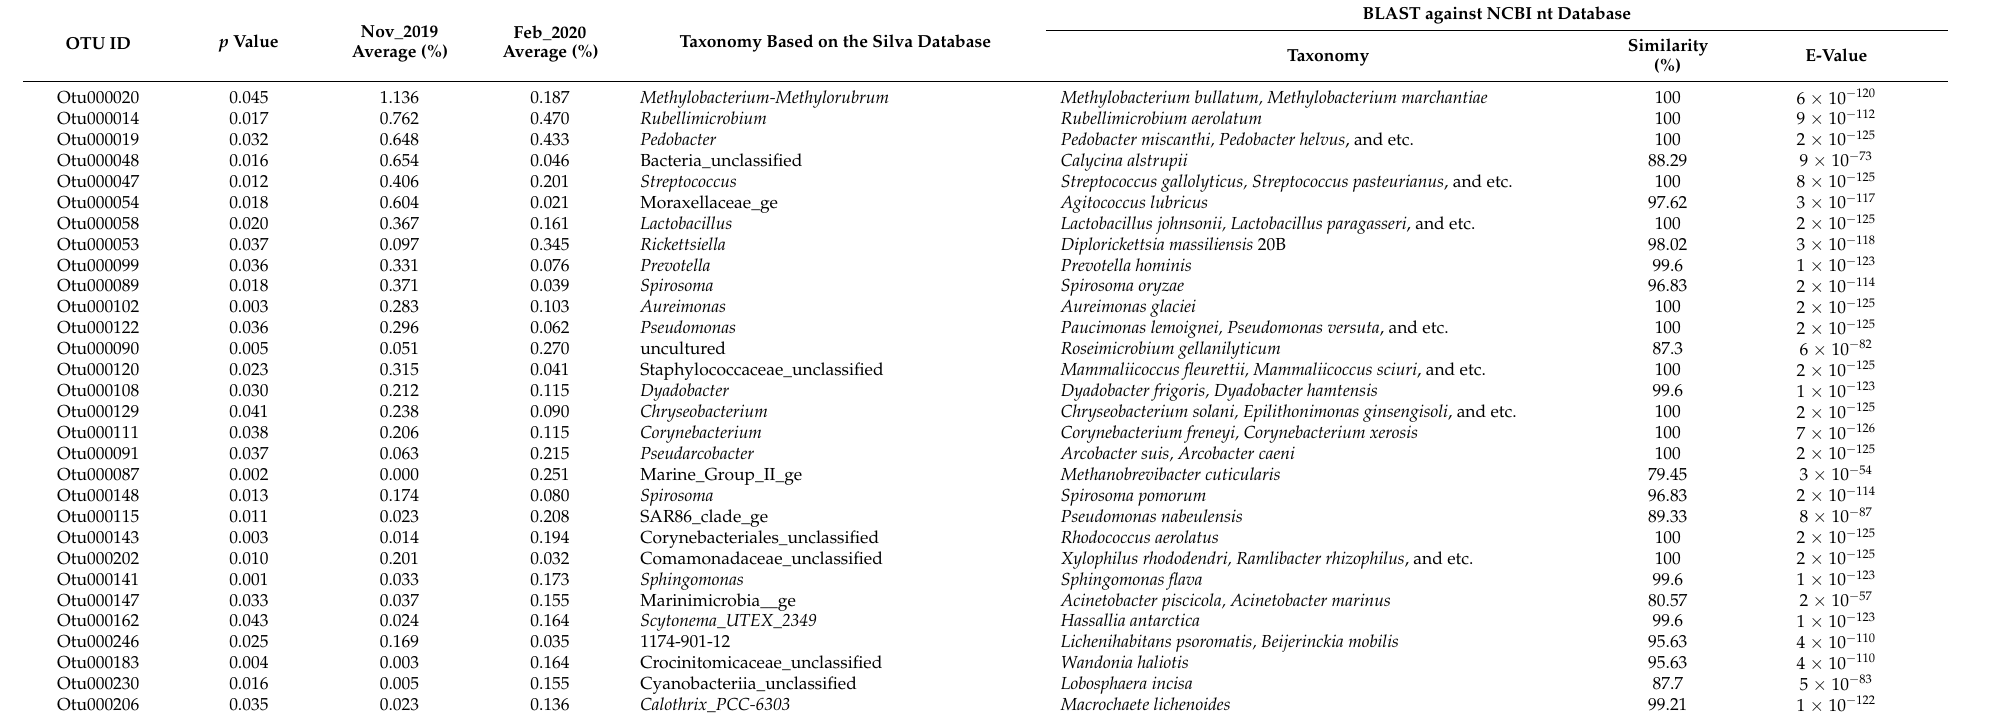
Table 2. t -test (or Wilcoxon test) results of the 30 most abundant prokaryotic OTUs that show significant difference in their relative abundance between the November 2019 samples and the February 2020 samples. Their taxonomic annotation based on the Silva database and their BLAST result against NCBI nt database (best hit score, classified down to species level) are shown